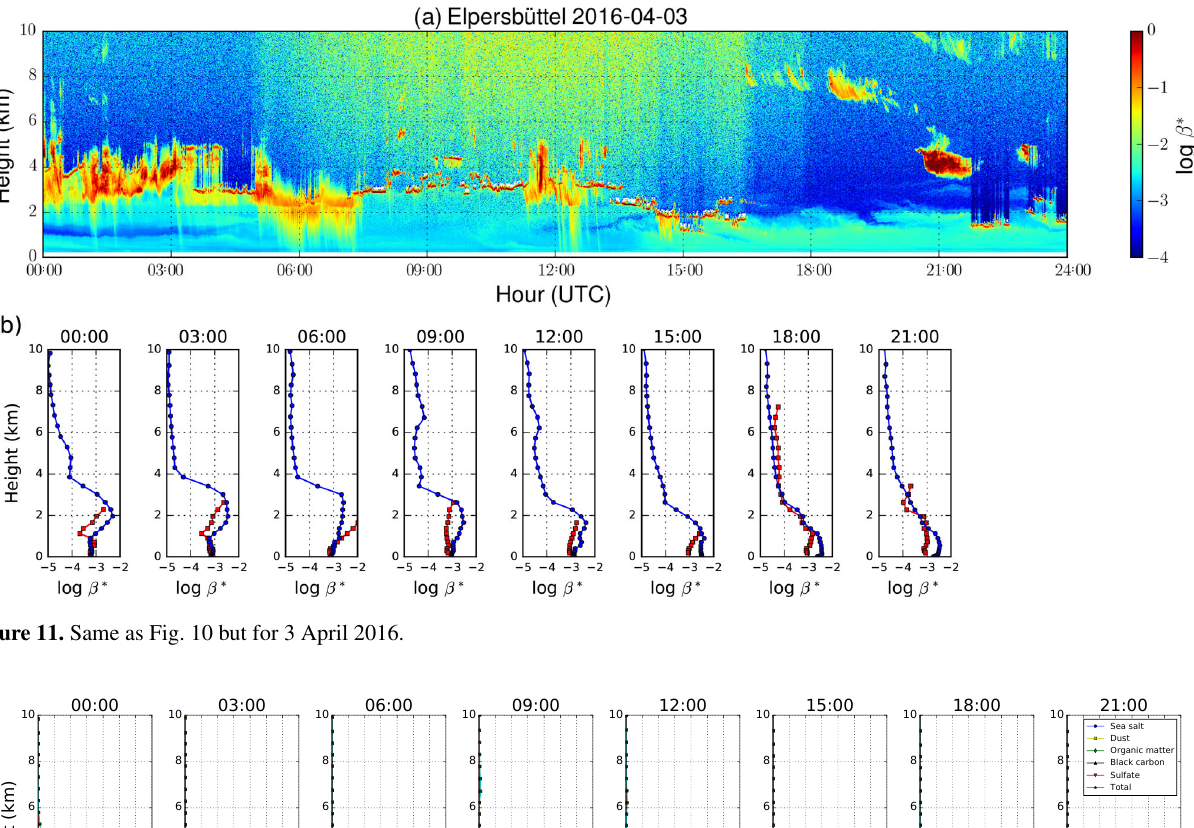
Figure 12. Time series of particle backscatter of the five aerosol types simulated by the model at Elpersbüttel during a dust episode on 3 April